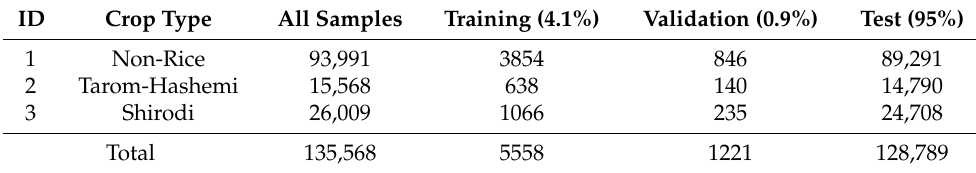
Table 1. A description of the statistical details of the reference